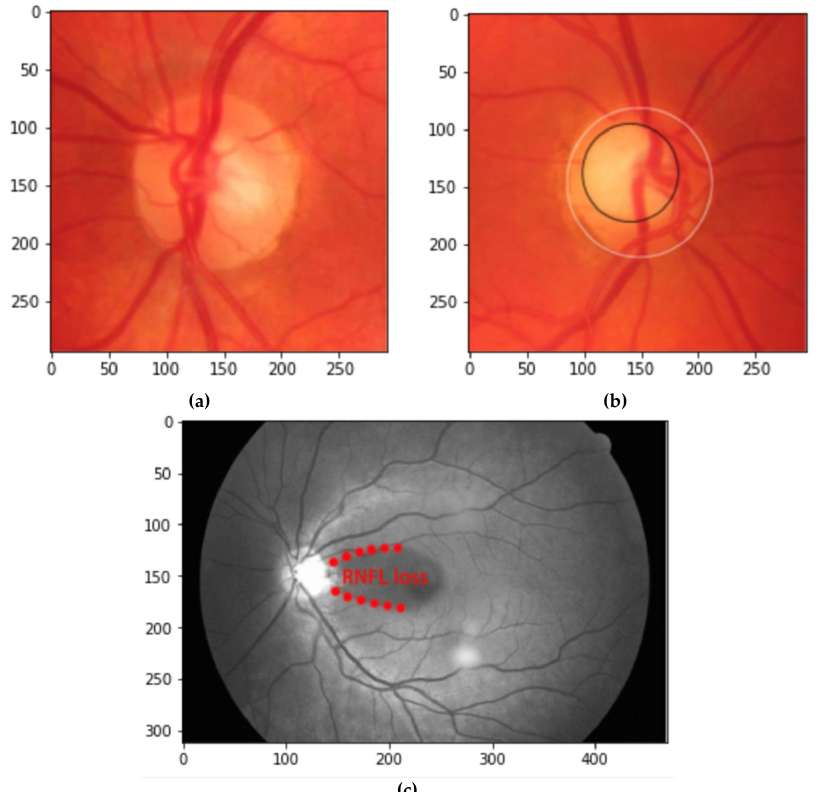
Figure 1. An example of ( a ) OD (marked by a white circle) and OC (marked by a black circle) indicates a healthy optic nerve, ( b ) OD (marked by a white circle) and OC (marked by a black circle) indicates a glaucomatous optic nerve and ( c ) glaucoma location [3,6].